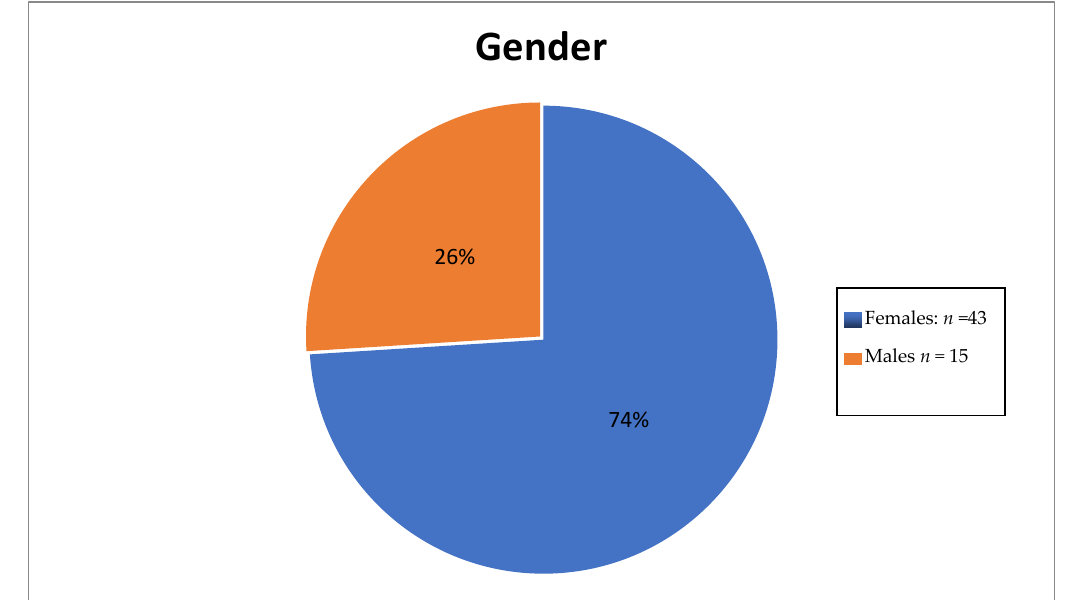
Figure 4. Pie chart showing gender disparity.